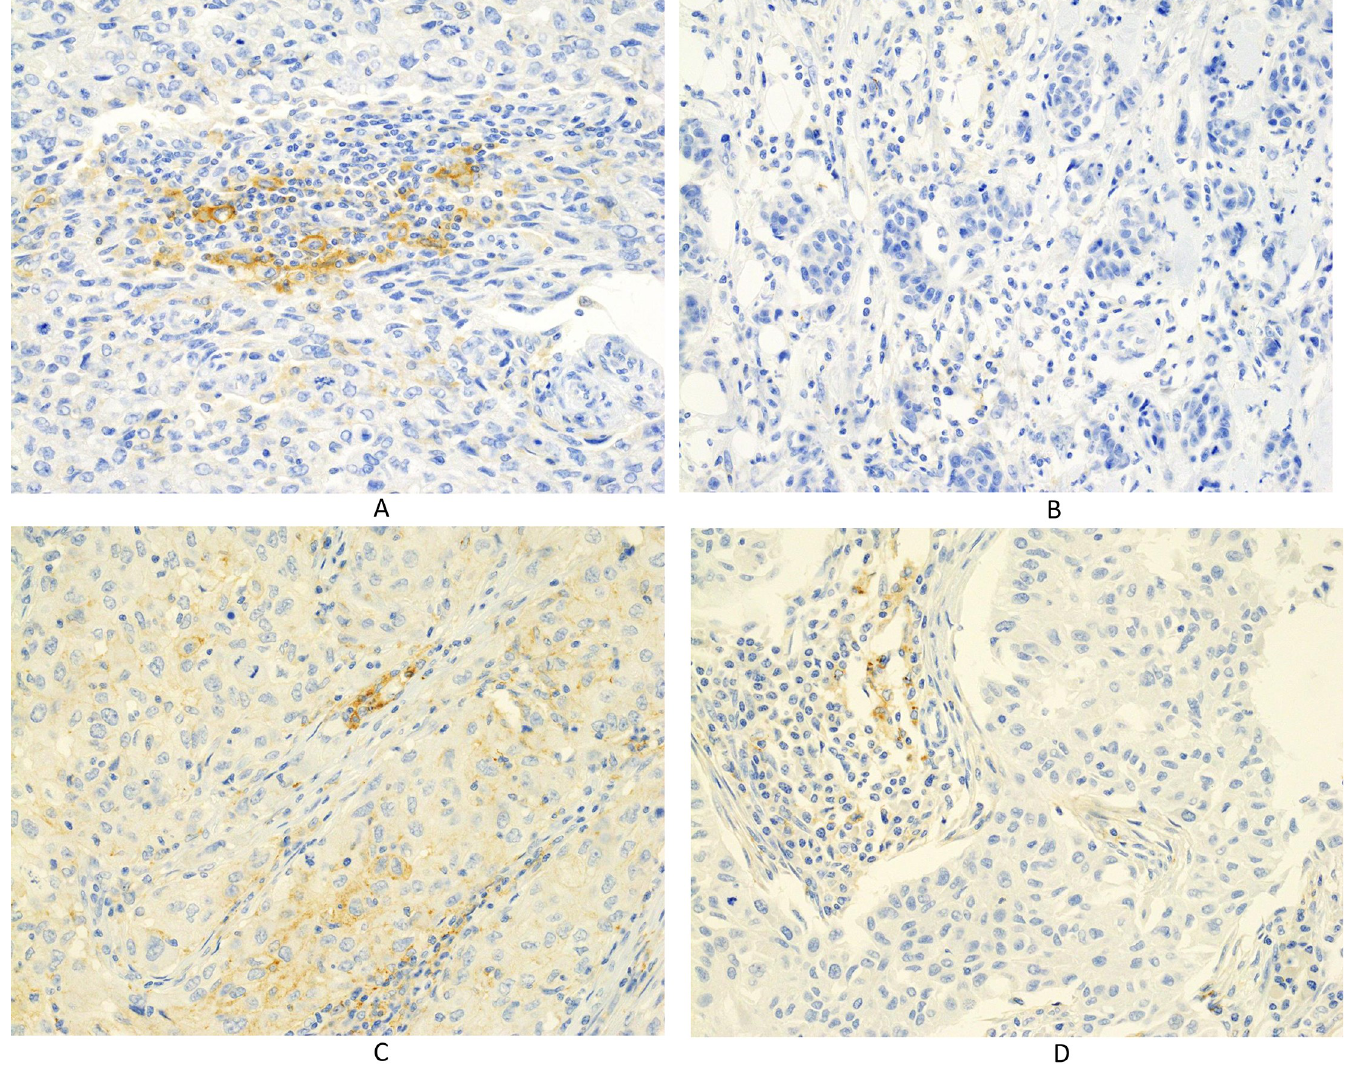
PLOS ONE | https://doi.org/10.1371/journal.pone.0257860 September 24,